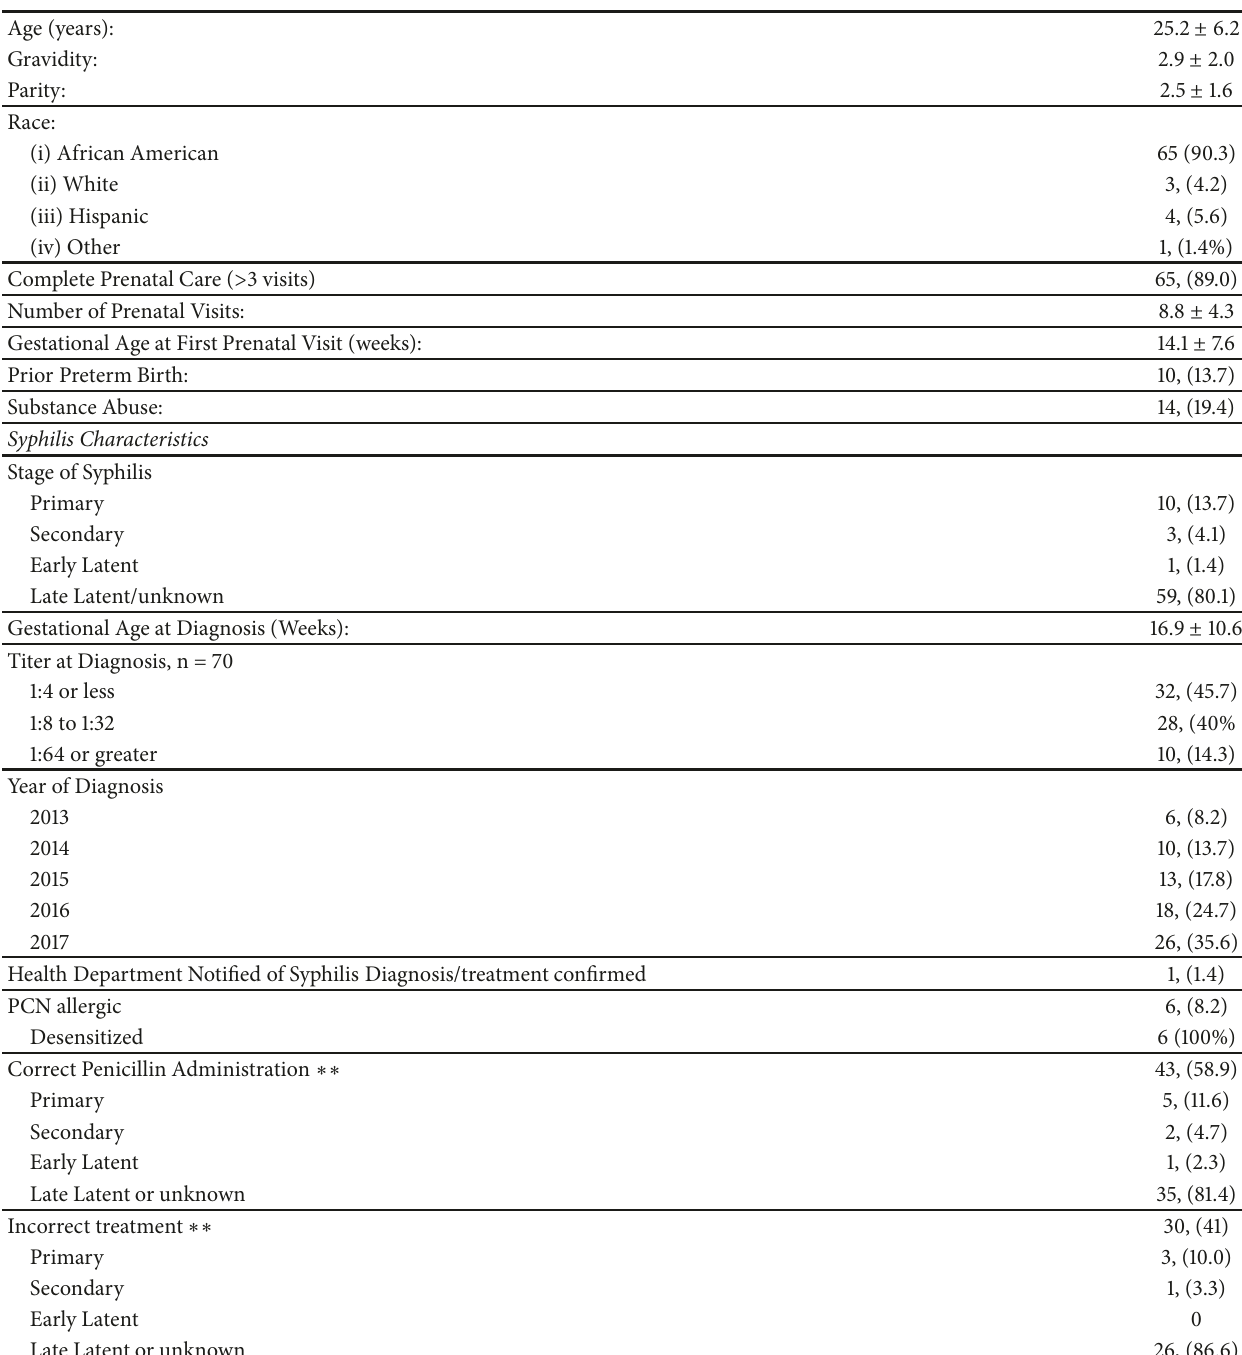
Table 1: Maternal demographics and syphilis characteristics: N =